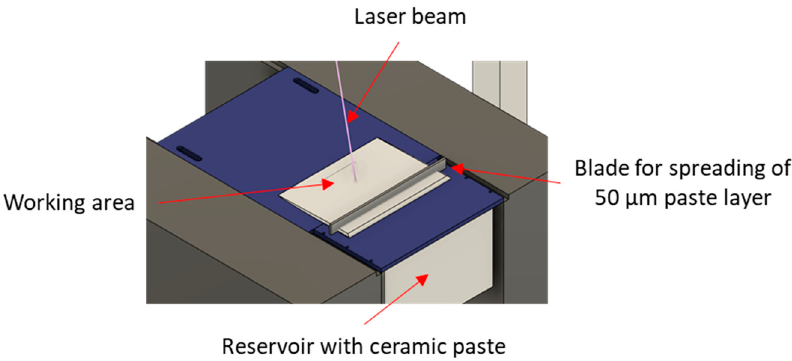
Figure 1. Stereolithographic printing process.